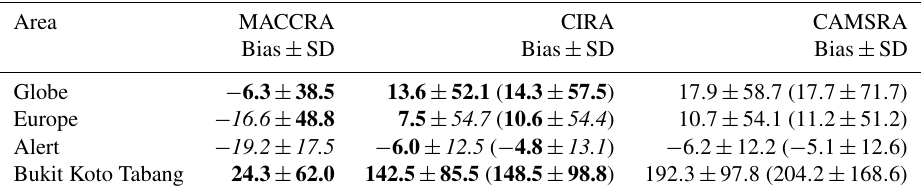
Figure 16. Top panels depict time series of monthly mean surface CO bias (in ppb) between the three reanalyses and GAW CO data averaged over (a) the globe and (b) Europe. Between 15 and 30 stations were available between 2003 and 2016, with largest number between 2008 and 2014 and smaller numbers in the earlier and later years. (c, d) Time series of monthly mean CO from GAW (blue dots), CAMSRA, CIRA and MACCRA (in ppb) at (c) Alert and (d) Bukit Koto Tabang. CAMSRA is shown in red, CIRA in blue and MACCRA in green. Table 6. Mean biases and standard deviations from MACCRA, CIRA and CAMSRA relative to GAW surface CO data (shown in Fig. 16; in ppb). The values are calculated for the period 2003–2012, and the values in brackets are calculated for CIRA and CAMSRA for the period 2003–2016. Numbers in italics mark where MACCRA or CIRA have larger biases or standard deviation than CAMSRA, and numbers in bold mark where their values are